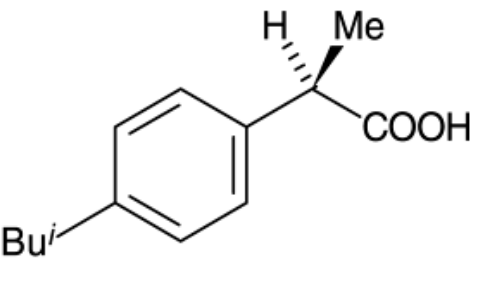
Figure 1. Chemical structure of ibuprofen.